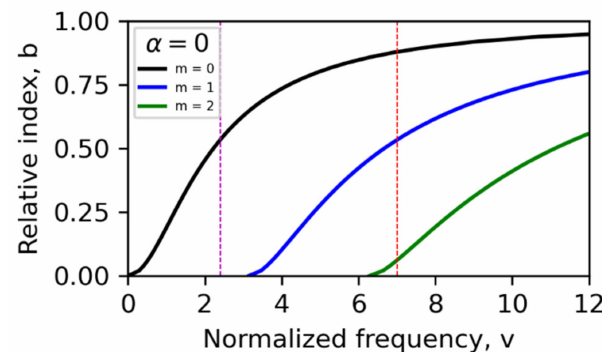
Figure 4. Relative index vs. normalized frequency chart for three modes for 320 nm-thick core in trans state. Trans state is design default state for operating wavelengths 340 and 450 nm. b values are marked by intersections of vertical line at v = 7.0 with mode charts.